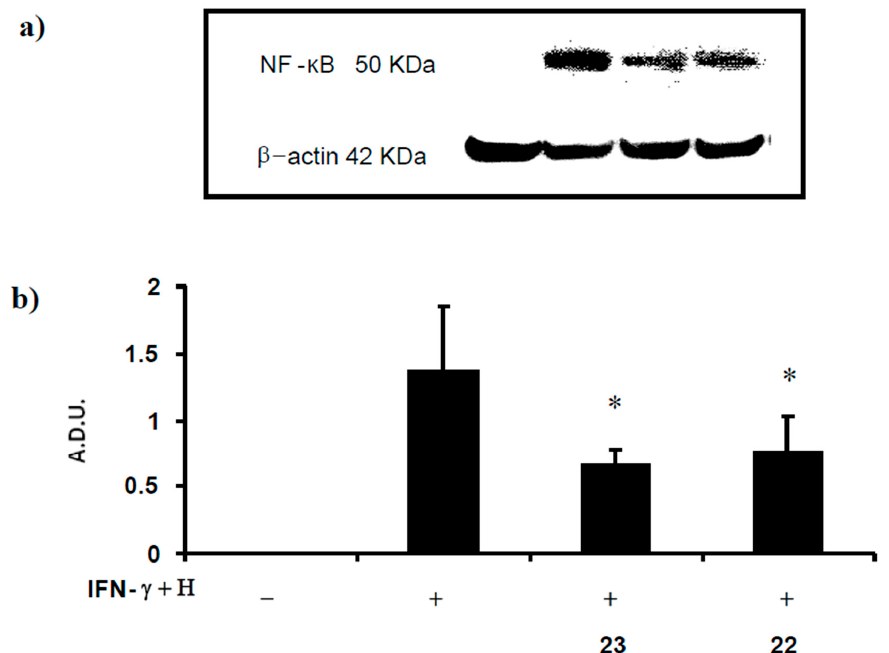
Figure 2. Effects of 22 and 23 on NF- κ B expression. ( a ) Representative blot; ( b ) Nuclear Factor-kappa B (NF- κ B) levels in cultures of human keratinocytes stimulated with IFN- γ and histamine (H), 48 h